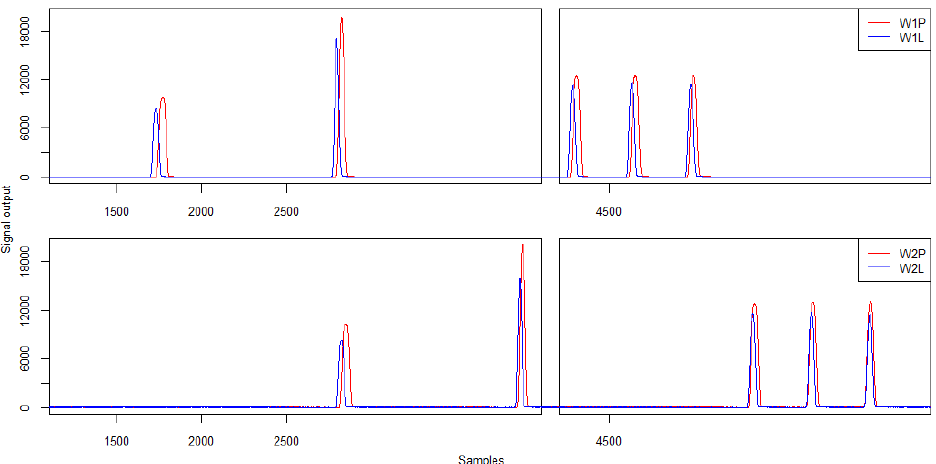
Figure 24. Example signals from strain gauges for changing the trajectory of a five-axle vehicle.